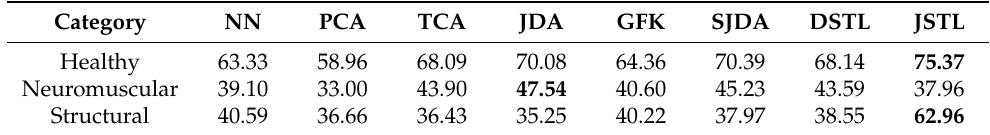
Table 6. Average accuracy (%) of different categories of different methods.